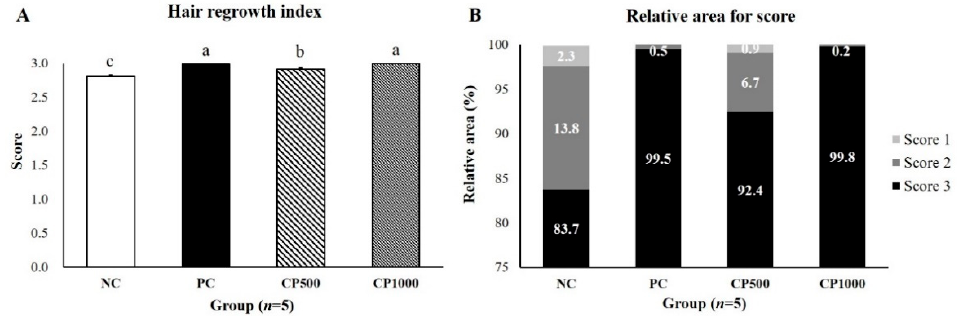
Figure 3. Effect of CP on hair regrowth score in depilation-induced C57BL/6 mice. ( A ) Hair regrowth score and ( B ) relative area for a score. The hair regrowth score was calculated by the skin dorsal photo on day 14. Differences were calculated by measuring the size of the complete black area (black skin) using the Image J program. Values with different superscript letters are significantly different ( p < 0.05). The results are reported as the mean ± SE ( n = 5/group). NC: negative control (distilled water); PC: positive control (finasteride, 1 mg/kg); CP500: collagen peptide, 500 mg/kg; CP1000: collagen peptide, 1000 mg/kg.